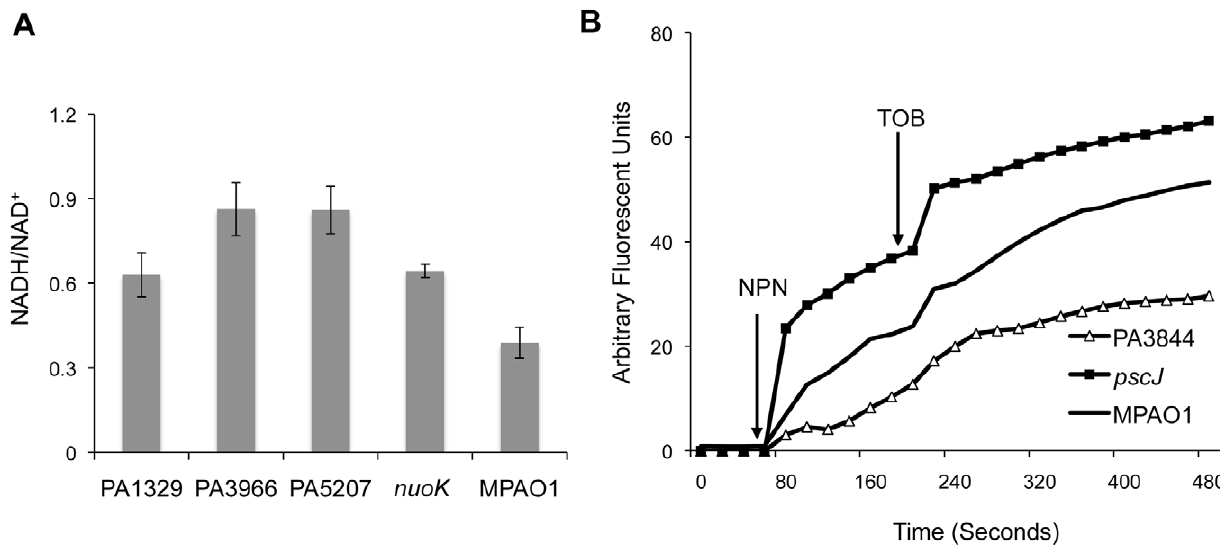
Figure 4. Functional classification of genes associated with antibiotic tolerance in biofilms. (A) The NADH/NAD + ratio was measured for a subset of mutants with the most pronounced growth advantage in the planktonic state with tobramycin. The NADH/NAD + ratios for the strains shown are significantly higher than wild-type (Student’s one-sided t-test p-values: 0.02, 0.002, 0.001, and 0.015 for mutants in PA1329, PA3966, PA5207, and nuoK , respectively). Error bars represent the standard error of at least three replicates. (B) The disruptive effect of tobramycin on the outer membrane of different mutants was measured using an NPN assay. NPN and tobramycin were added at the indicated times.